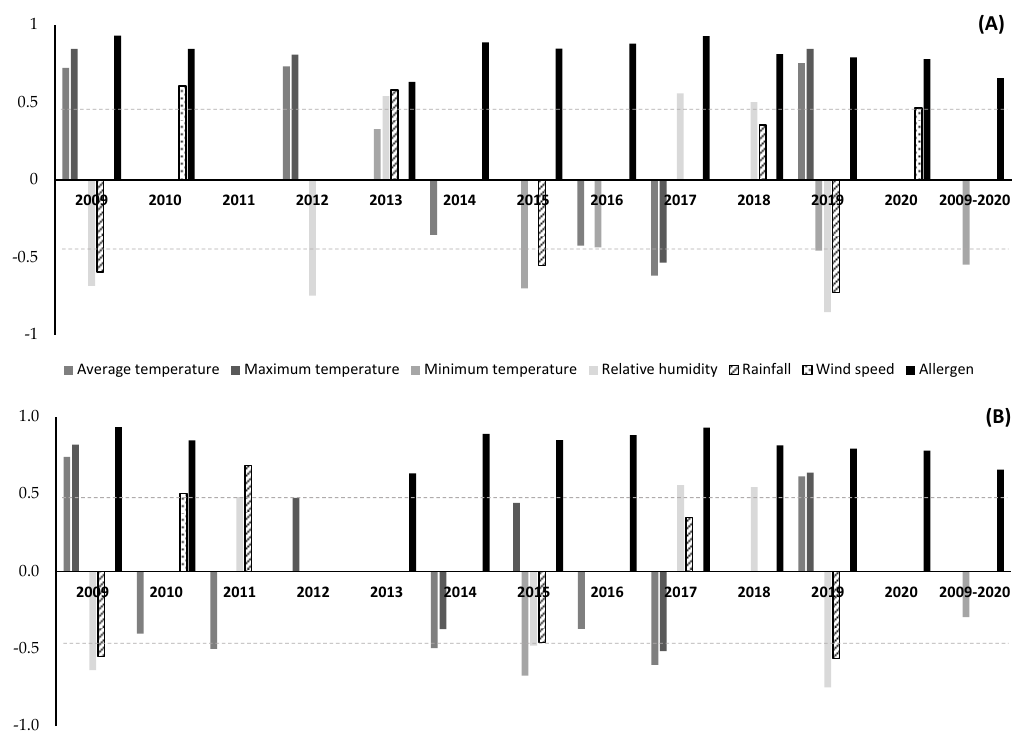
Figure 4. Spearman correlations between pollen ( A ) or allergen ( B ) and the main meteorological variables in each year and all study years. The dotted line means that above the line the significance level is p < 0.01.